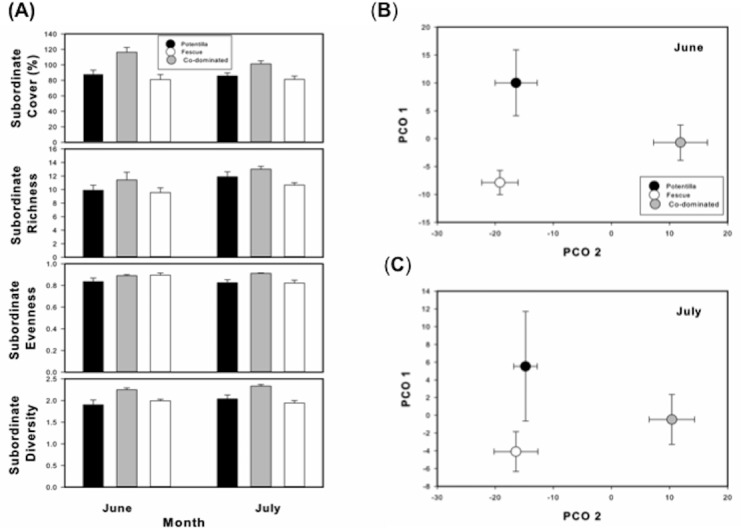
Subordinate diversity and composition across a plant dominance gradient.(A) Mean (±standard error) subordinate species’ cover, richness, evenness and diversity across a plant dominance gradient (Potentilla dominated, Potentilla and Festuca co-dominated, Festuca dominated) for June and July of 2014. (B) Principal Coordinate Ordination (PCO) illustrating in a two-dimensional scale (PCO Axis 1 and PCO Axis 2) subordinate species composition across a plant dominance gradient (Potentilla dominated, Potentilla and Festuca co-dominated, Festuca dominated) (observational study) for June and (C) July of 2014.